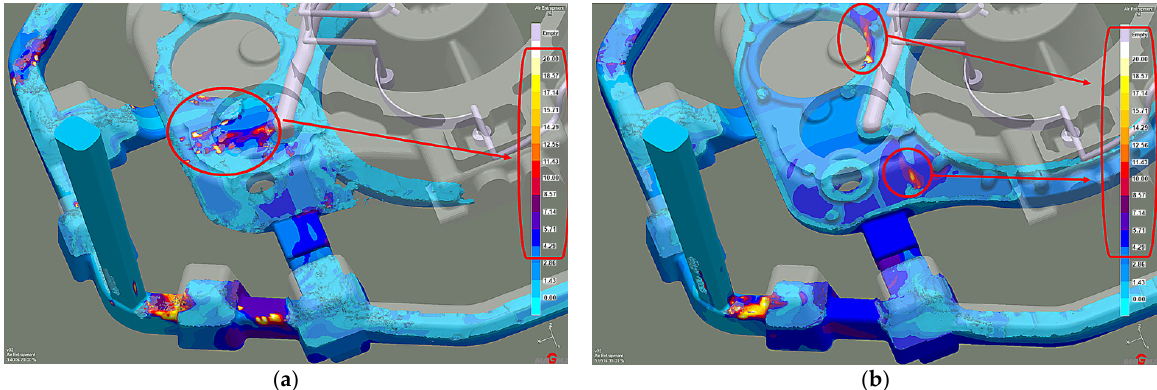
Figure 9. Stage 2 Liquid metal-air entrapment: ( a ) 20% of mold filling; ( b ) 35% of mold filling. The increased liquid melt flow rate through the individual feeding gates moves the air-liquid metal mixture into the casting regions where the hot spots (oil channels, flanges) occur. Less entrapped air reduces casting porosity. WD1 and WD4 feeding gates are de- fect-free. However, in the WD3 feeding gate, the porosity decreased from 70% to about 13% (Figure 10).